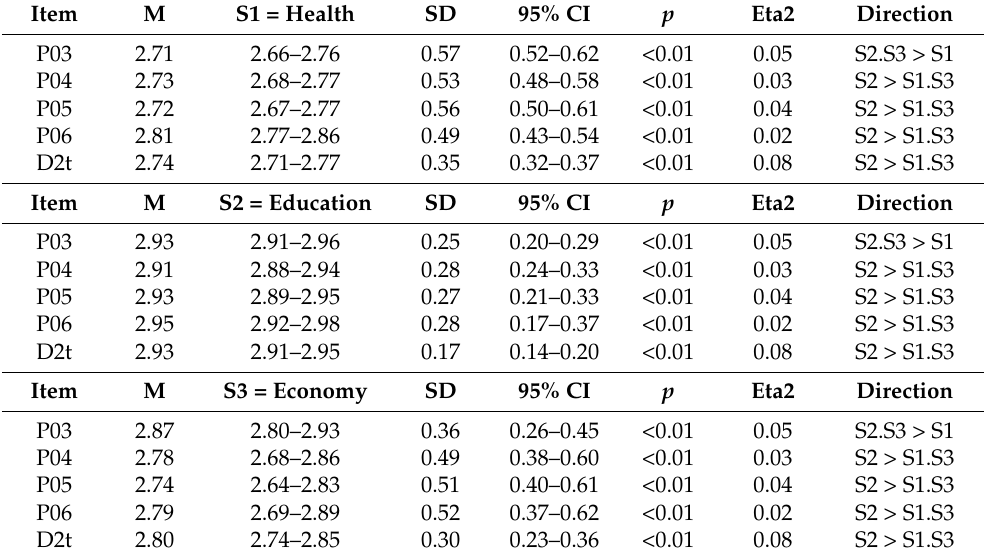
Table 8. ANOVA for sector-independent samples for dimension